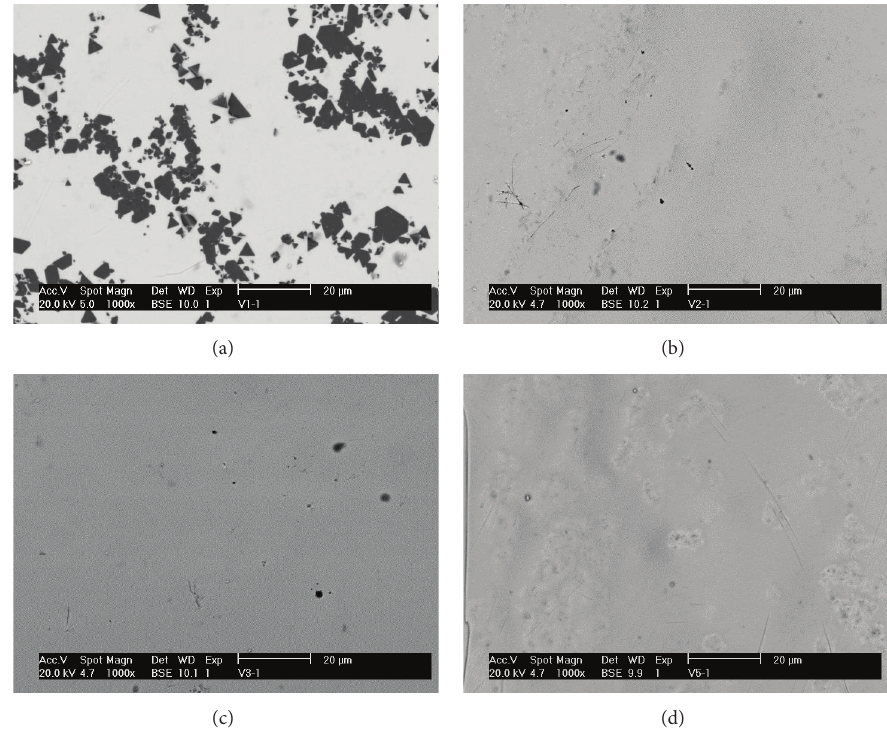
Figure 1: Micrographs of glasses surface: (a) V1, (b) V2, (c) V3, and (d) V5.